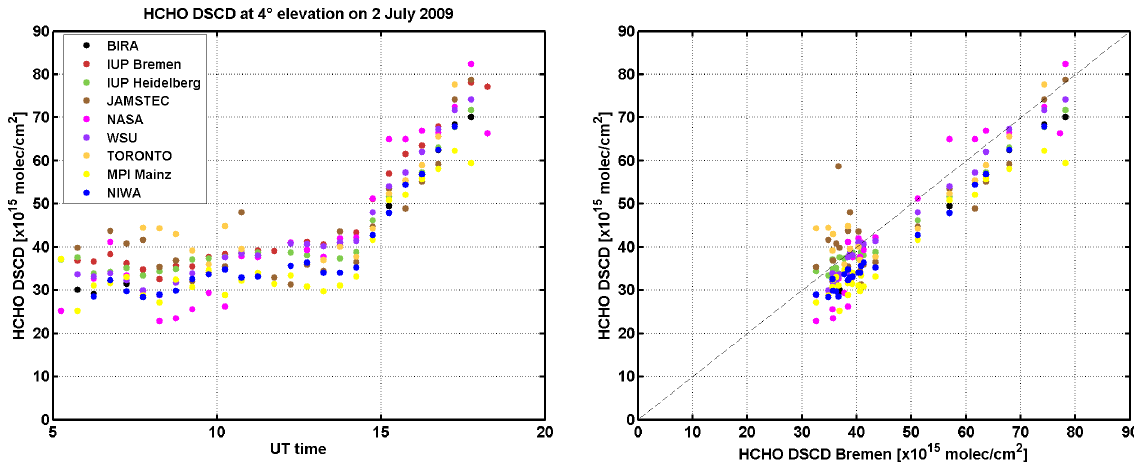
Fig. 12. Formaldehyde (HCHO) differential slant column density intercomparison for the data obtained on 2 July 2009 by all systems listed in the legend. The left panel shows the evolution over the day of the 30-min averaged slant columns retrieved from the 4 ◦ elevation angle data, while the right panel shows their scatter plot with respect to the Bremen instrument (Pinardi et al., 2012).